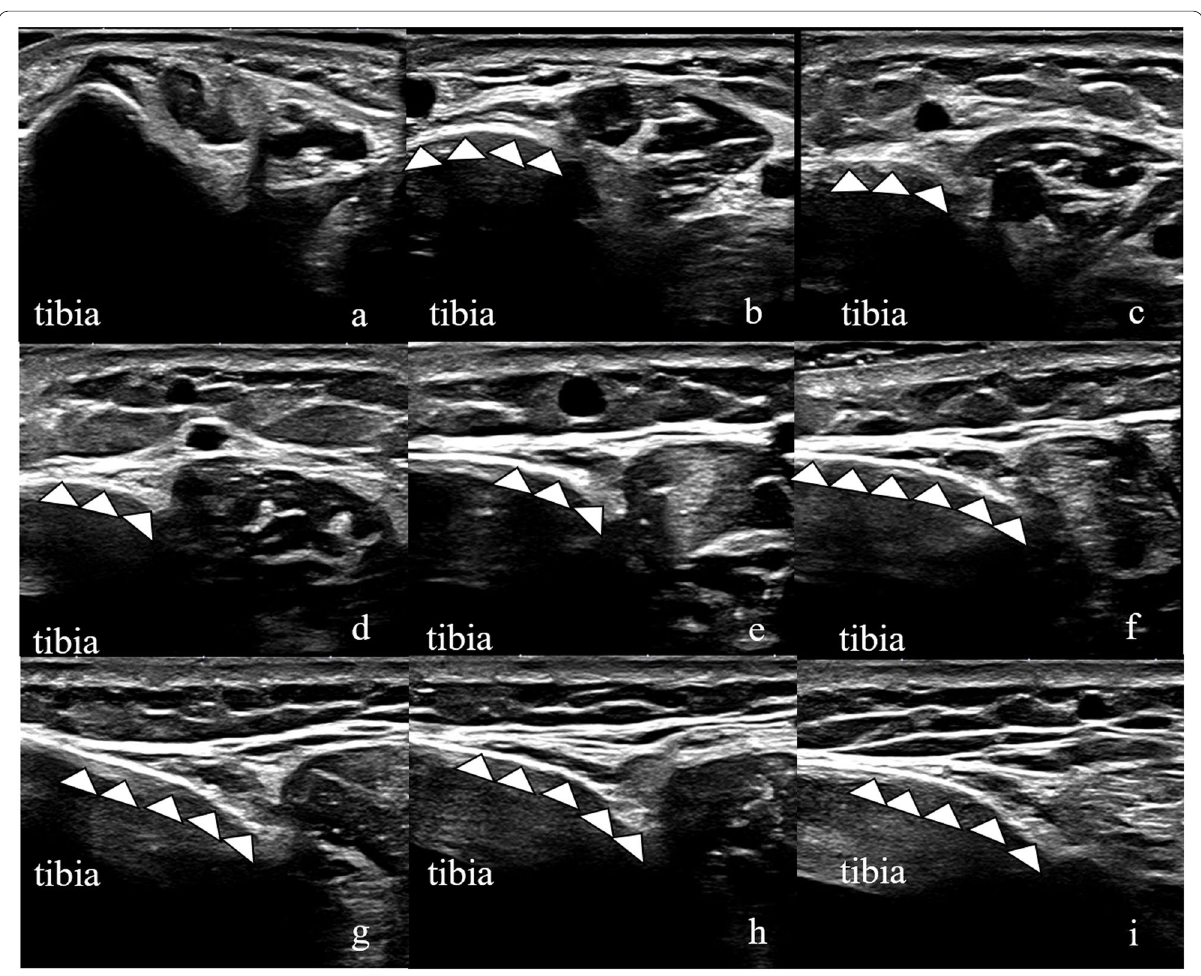
Fig. 6 A 22-year-old man. Ultrasound images of the transverse axis of the medial calf. The adipose tissue is visualised with high echogenicity (white arrows). Images acquired at a : 3 cm; b : 6 cm; c : 9 cm; d : 12 cm; e : 15 cm; f : 18 cm; g : 21 cm; h : 24 cm; and i : 27 cm from the distal tip of the medial malleolus. These images are from the same participant as in Fig.